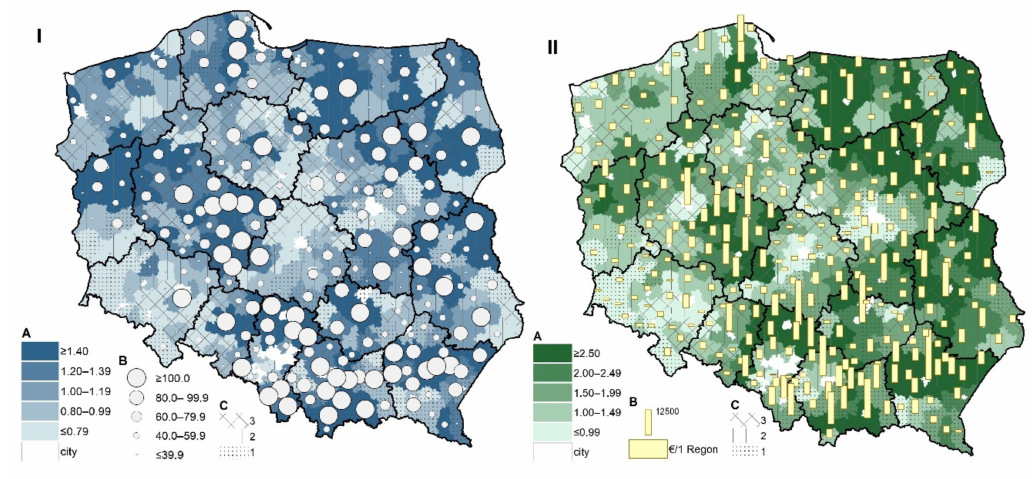
Figure 4. Measure of “Establishment and development of micro-enterprises”. ( I ) Number of applications (See Table 1): inhabitants (A), total (A); ( II ) per 100 Regon entities (A) and amount from 1 Region entity (B); C—agricultural conditions: (1) low; (2) average; (3) high; Source: own study based on data from ARMA and LDB CSO,